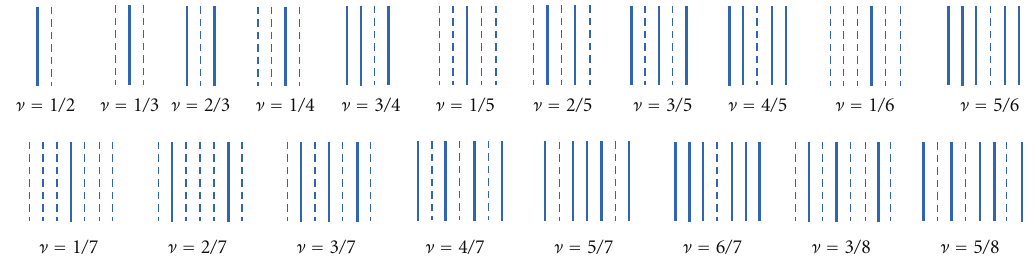
Figure 6: Most uniform unit arrangements of electron configuration.